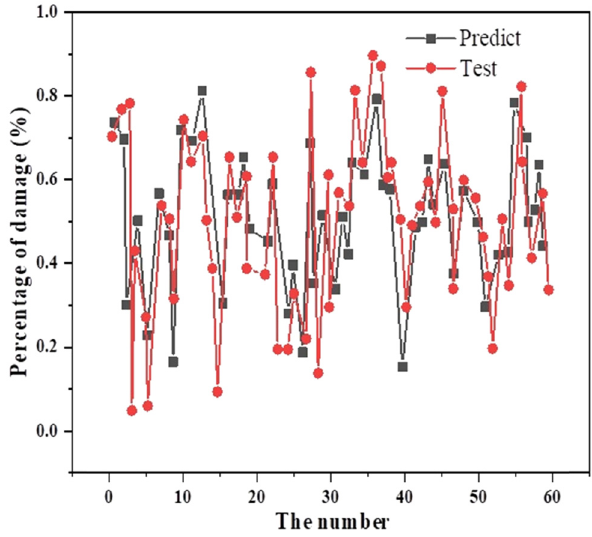
Figure 7: Fitting degree of structural damage based on CPSO - BP training.